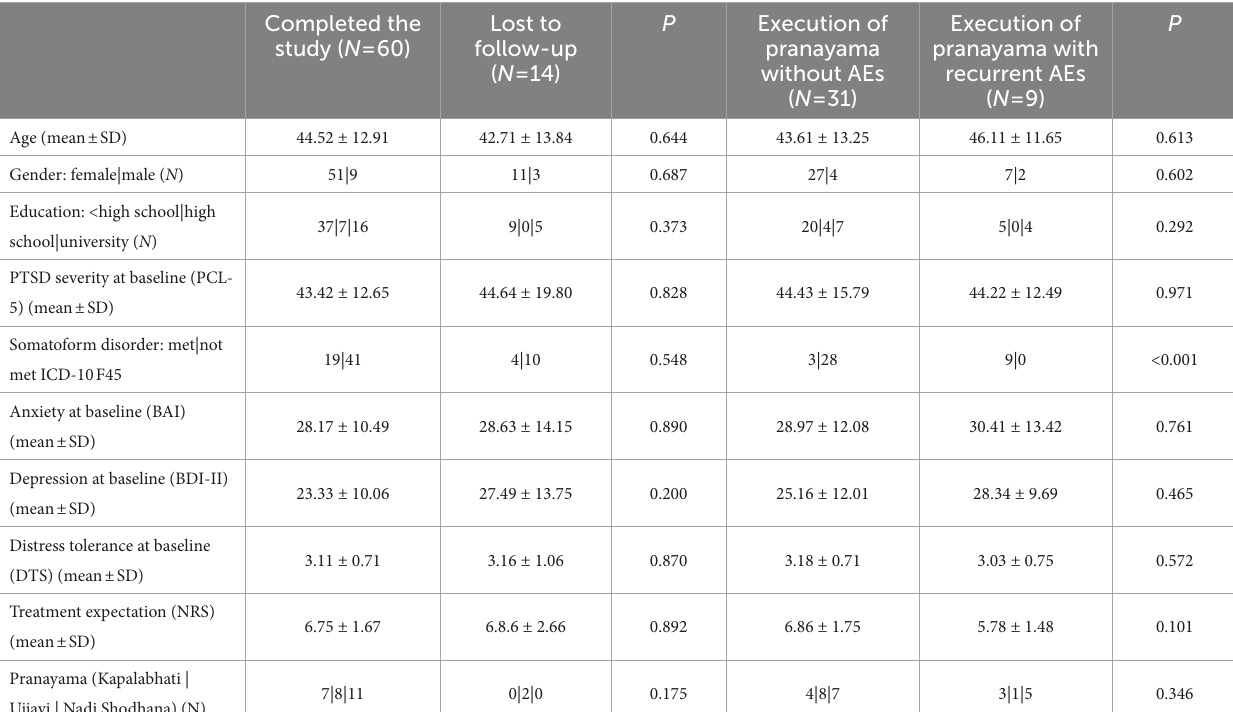
TABLE 3 Dropout